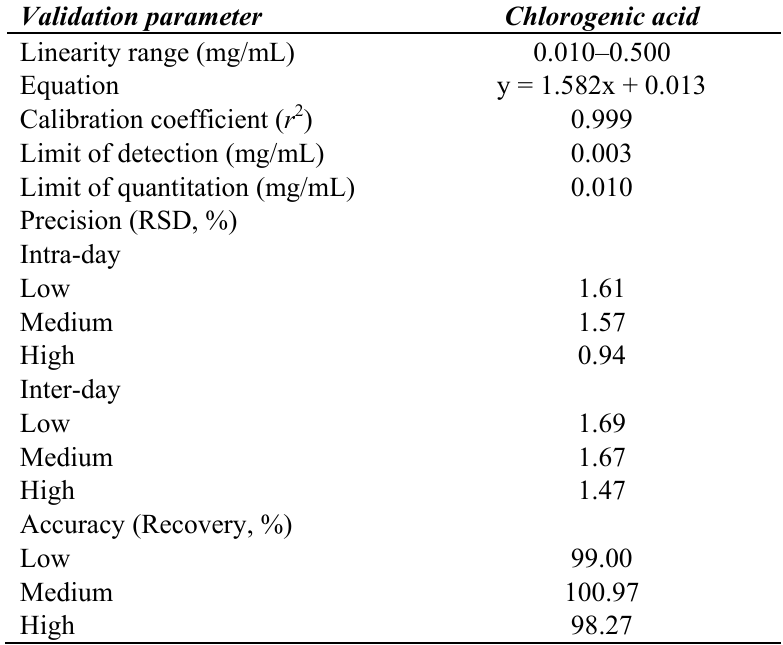
Table 2. Validation data of total phenolic acids